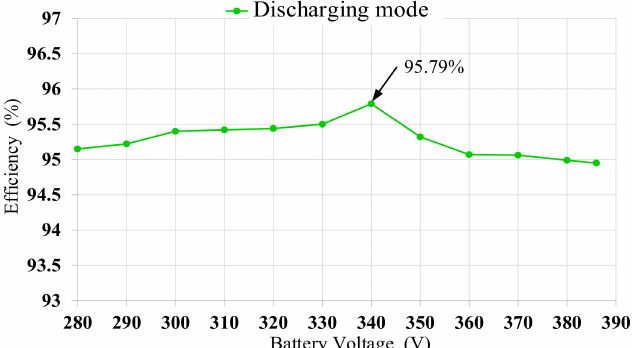
Figure 23. Constant power discharging efficiency curve of the fabricated converter.